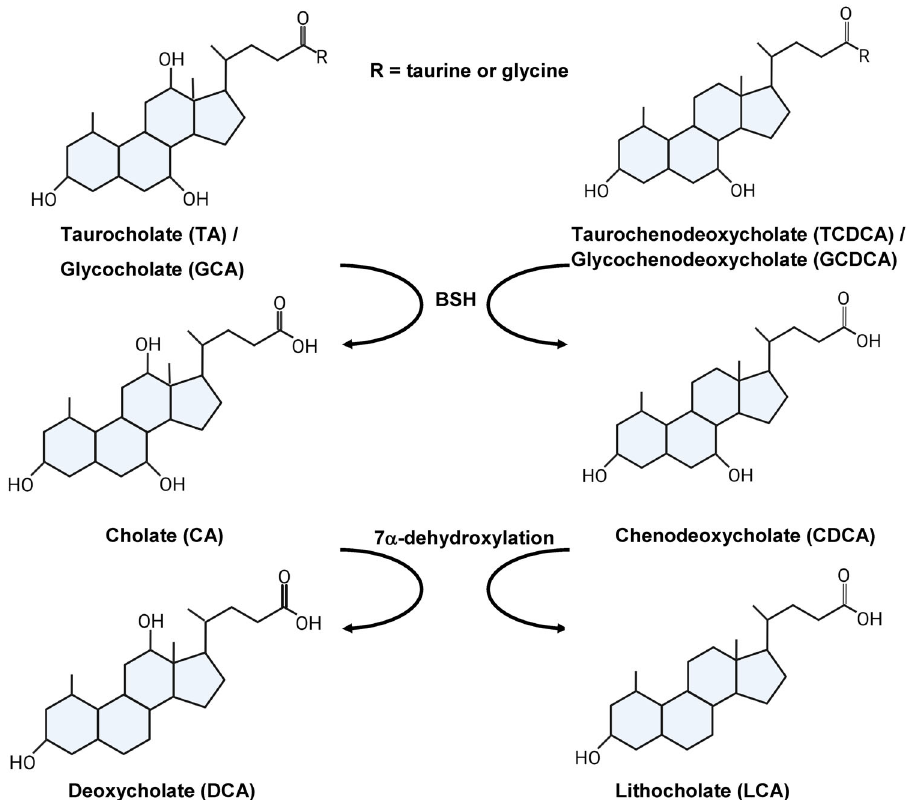
Fig. 1 Host bile salts and derivatives. The two primary bile acids, cholate (CA) and chenodeoxycholate (CDCA), can be conjugated with taurine or glycine. Many bacteria in the gut can remove the conjugated amino acid (deconjugation) to generate the base bile salt. The deconjugated bile acids undergo 7 α -dehydroxylation, performed by a small percentage of gut microbes, to generate the secondary bile salts deoxycholate (DCA) from CA and lithocholate (LCA) from